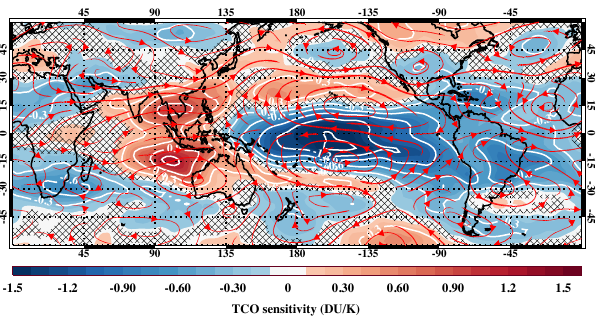
Figure 3. The deseasonalized TCO variance explained by ENSO from the linear regression over 2005–2013. Crosshatched areas de- note where the confidence level of the explained variance being dif- ferent from zero is less than 95%. The increment of the white con- tours is 5%.